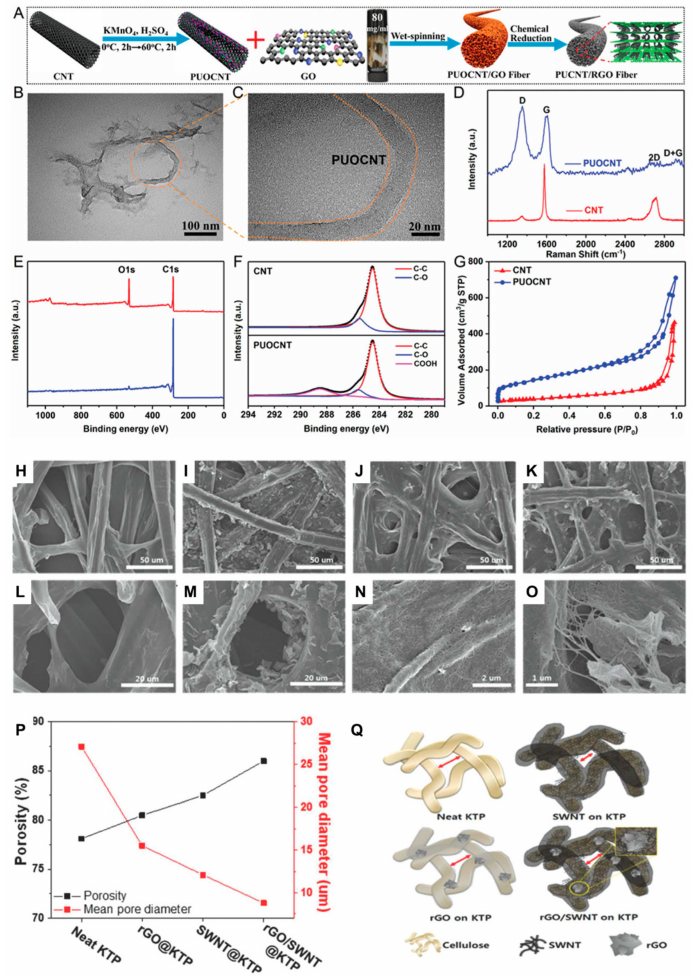
Figure 8. ( A ) Schematic illustration of PUOCNT synthesis and of PUCNT/RGO fiber fabrication. ( B , C ) TEM images of PUOCNT. ( D ) Raman spectra, ( E ) XPS survey spectrum, ( F ) XPS C1s